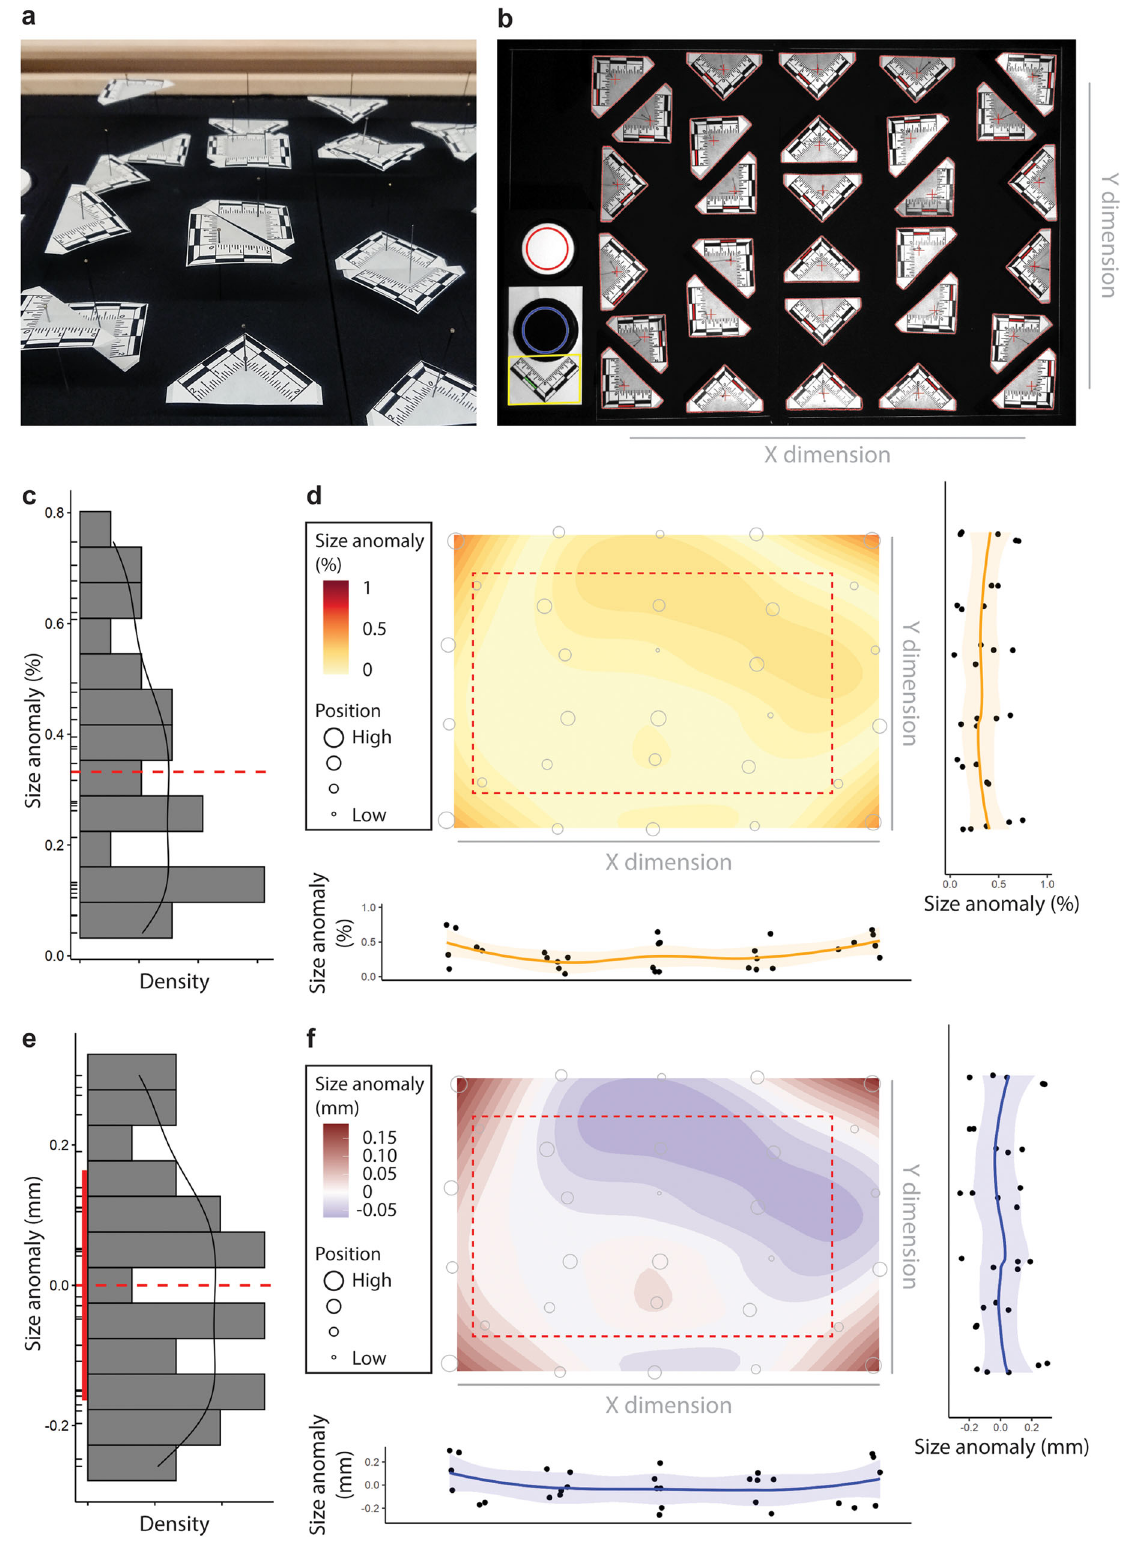
Fig. 7 Empirically measured lens-induced measurement distortion. a Illustration of scale standards placed at different heights on pins. b View of the image taken by the imaging system. c, d Frequency distribution c and spatial distribution d of size anomalies in absolute percentage compared to a 4 cm butter fl y. e, f The raw value for d & e is provided. The dashed line in c & e indicates median and zero, respectively. The region bounded by the red dashed line in d , f are where we place our specimens for